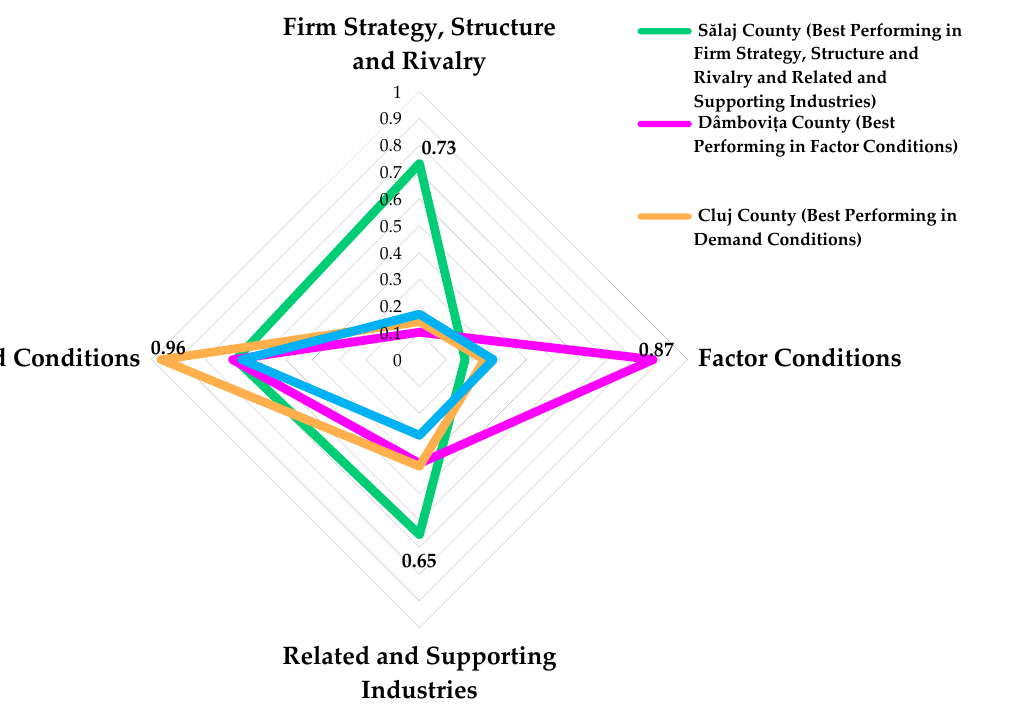
Figure 5. Best-performing Romanian counties in relation to Porter’s diamond model attributes. Source: authors’ own graphical representation and design based on data from Table 8.